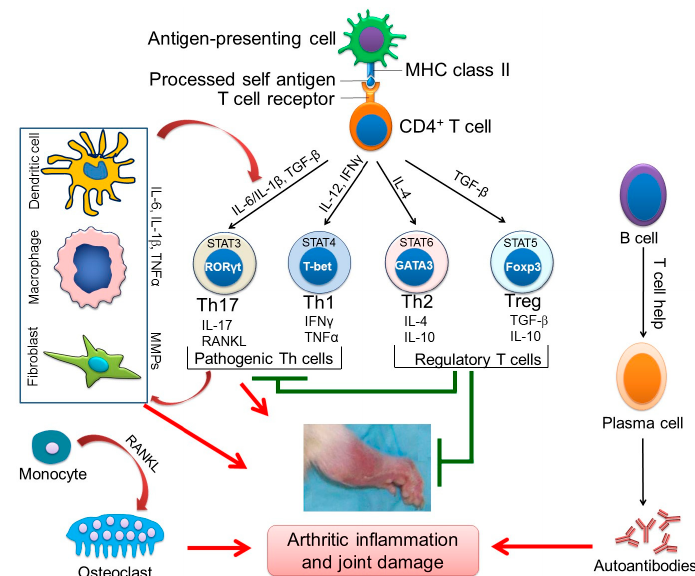
Figure 1. Immunopathogenesis of experimental autoimmune arthritis. Schematic representation of the key pathways is shown: The presentation of an autoantigen to autoreactive T cells and their differentiation into major T helper (Th) cell subsets under the influence of various cytokines; the activation and secretion of pro-inflammatory cytokines by myeloid cells; the T-B cell collaboration leading to autoantibody production by plasma cells; and the osteoimmune cross-talk leading to osteoclast differentiation. These intricate pathways regulate autoimmune inflammation of the synovial joint as shown by arrows (leading to activation/induction) and blunt ends (leading to suppression/inhibition).